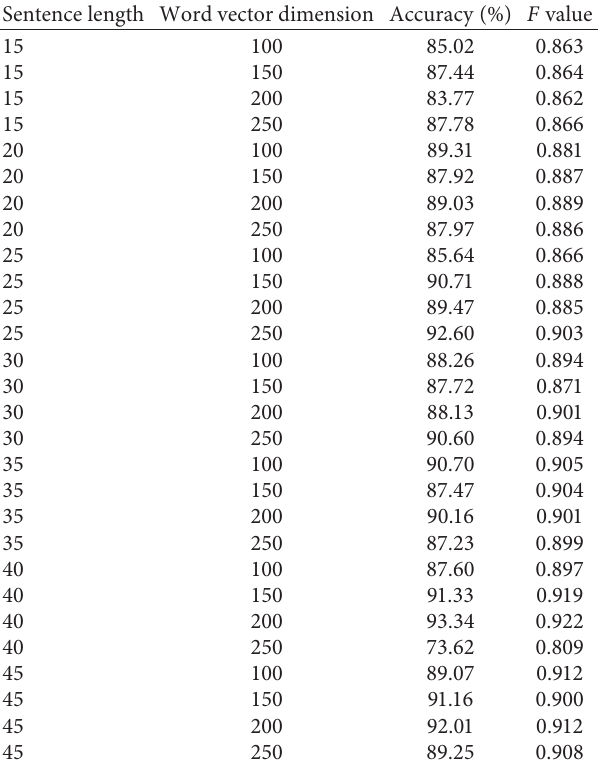
Table 6: GRU classification